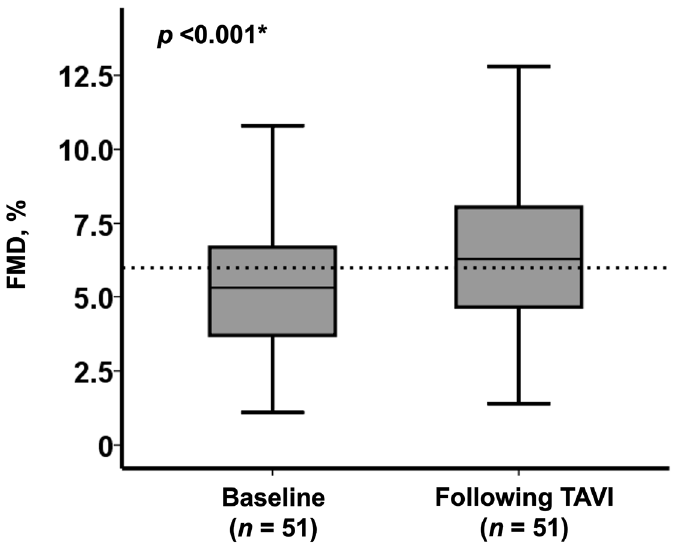
Figure 1. Change in FMD following TAVI in the overall cohort ( n = 51) * p < 0.05 by Wilcoxon signed-rank test.